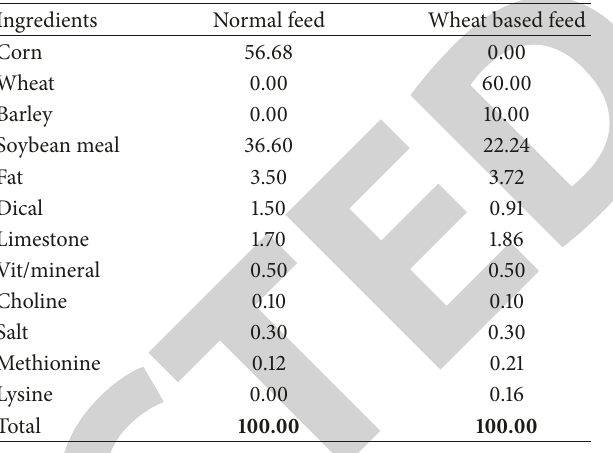
Table 1: Ingredients and composition of feed used in experimental studies ( percent w/w